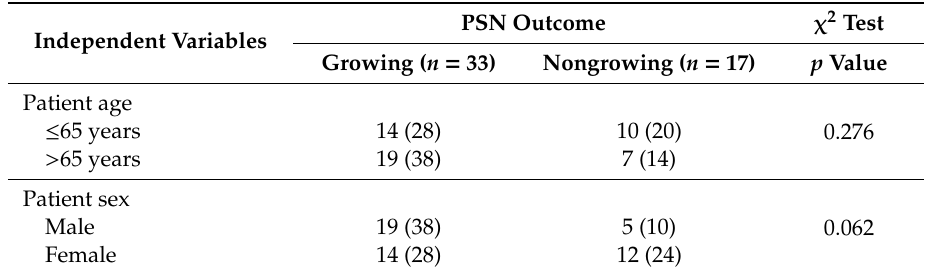
Table 4. Associations between part-solid nodule (PSN) growth and independent variables (patient age, sex, smoking history, oncologic history, emphysema status and PSN lobe